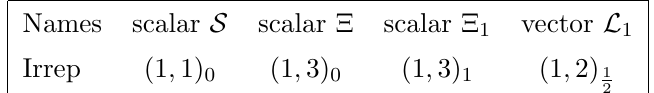
Table 5 . New particles in the simpli(cid:12)ed model that we consider as examples of UV completion. (cid:15) In UV completions where new degrees of freedom dominantly couple to the longitudi- nal modes of electroweak gauge bosons, positivity bounds carve out a 3-dimensional triangular pyramid in the S